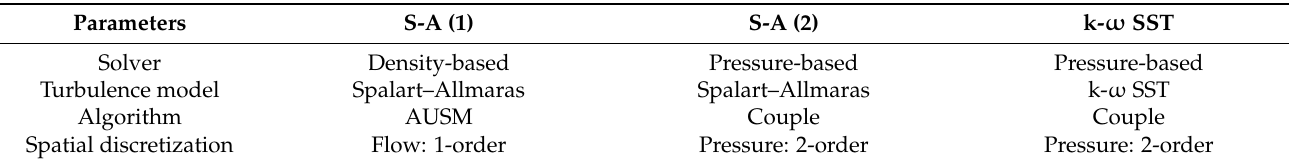
Figure A3. Comparison of pressure coefficient in airfoil surface of the wing elements as single configuration and baseline configuration (CFD results): ( a ) upper element; ( b ) lower element.